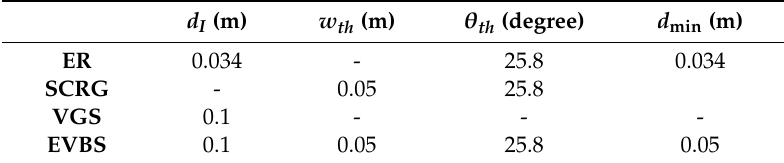
Table 1. Parameter settings for experiment using terrestrial laser scanner